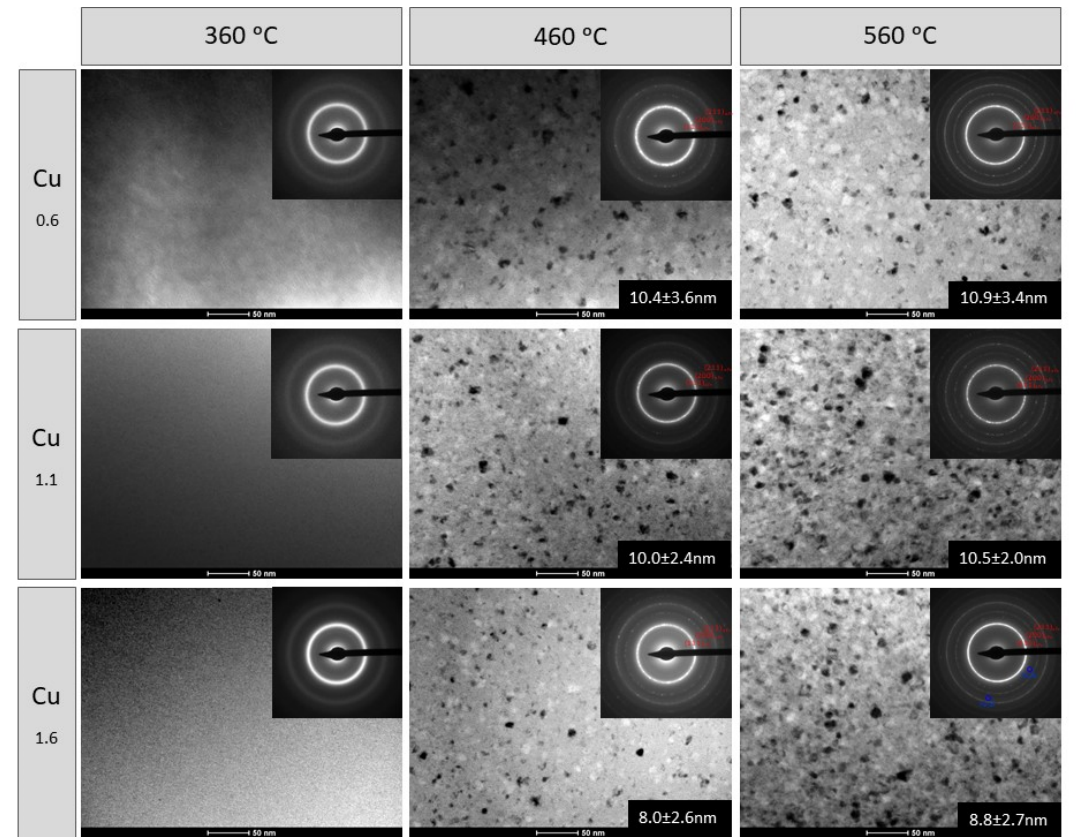
Figure 8. Microstructural evolution of Fe 72 − x Ni 8 Nb 4 Cu x Si 2 B 14 .